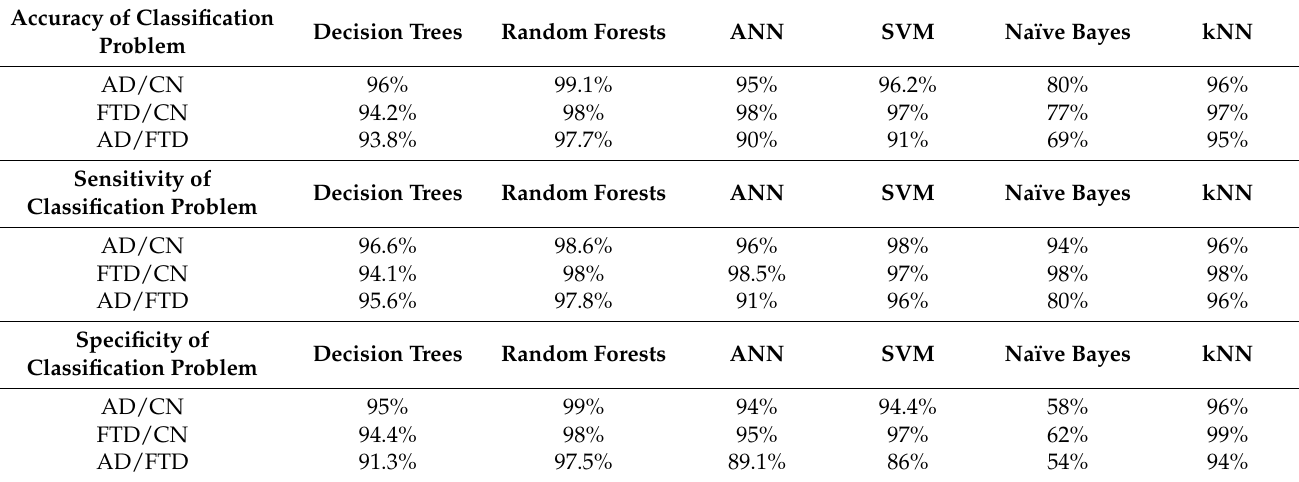
Table 2. Accuracy, sensitivity, and specificity results of six classification algorithms using 10-fold cross validation. Accuracy of Classification